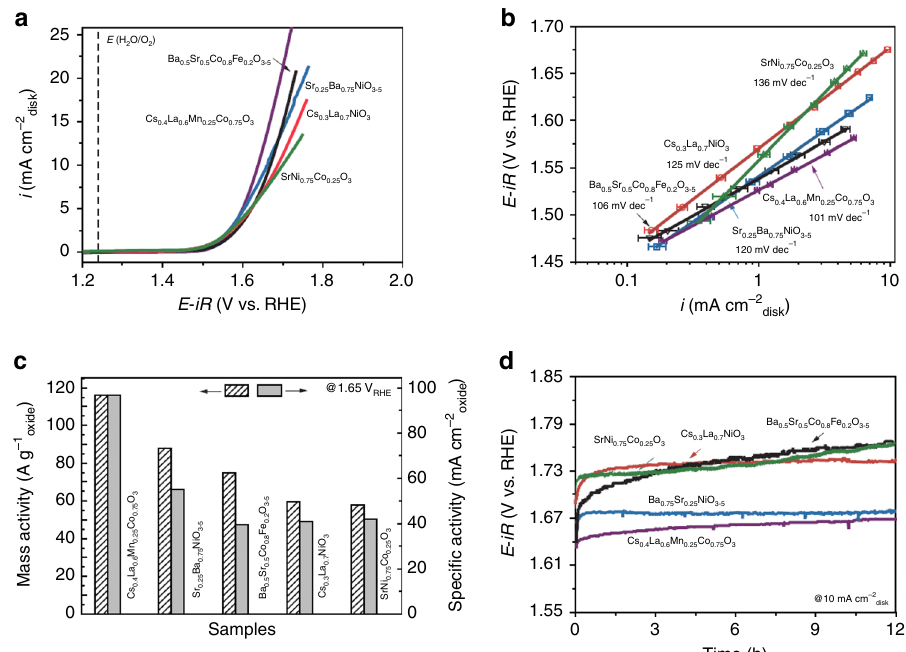
Fig. 4 OER characterisations of Ba 0.5 Sr 0.5 Co 0.8 Fe 0.2 O 3 and predicted new oxide perovskites. a LSV curves. b Corresponding Tafel slopes. c Mass